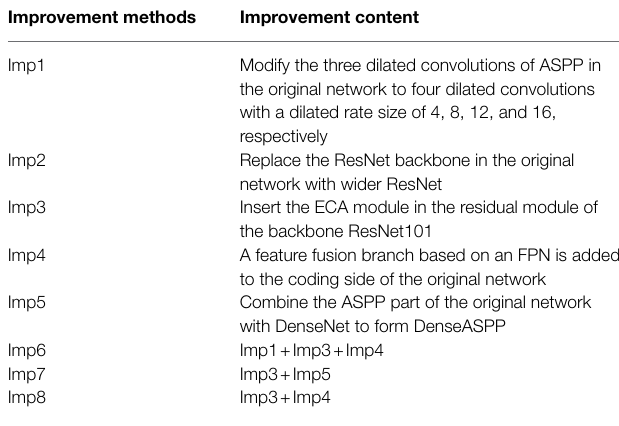
TABLE 1 | Different DeepLab v3+ improvement